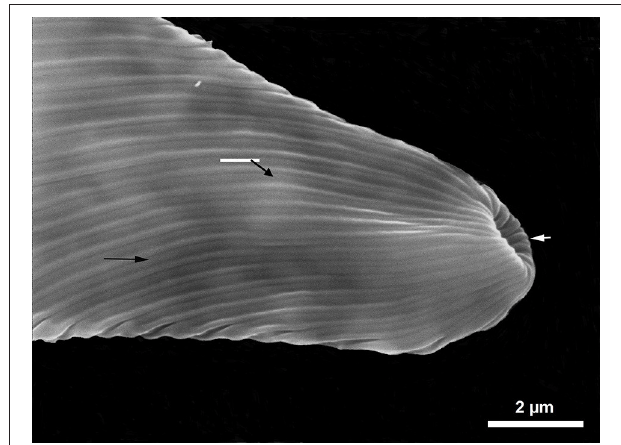
FIGURE 4 | SEM photography new strips (arrows) can be observed between old ones.